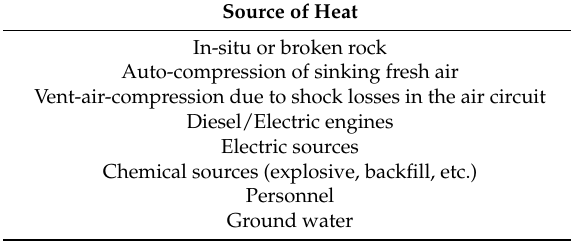
Table 1. Different sources of heat for a subsurface mining operation